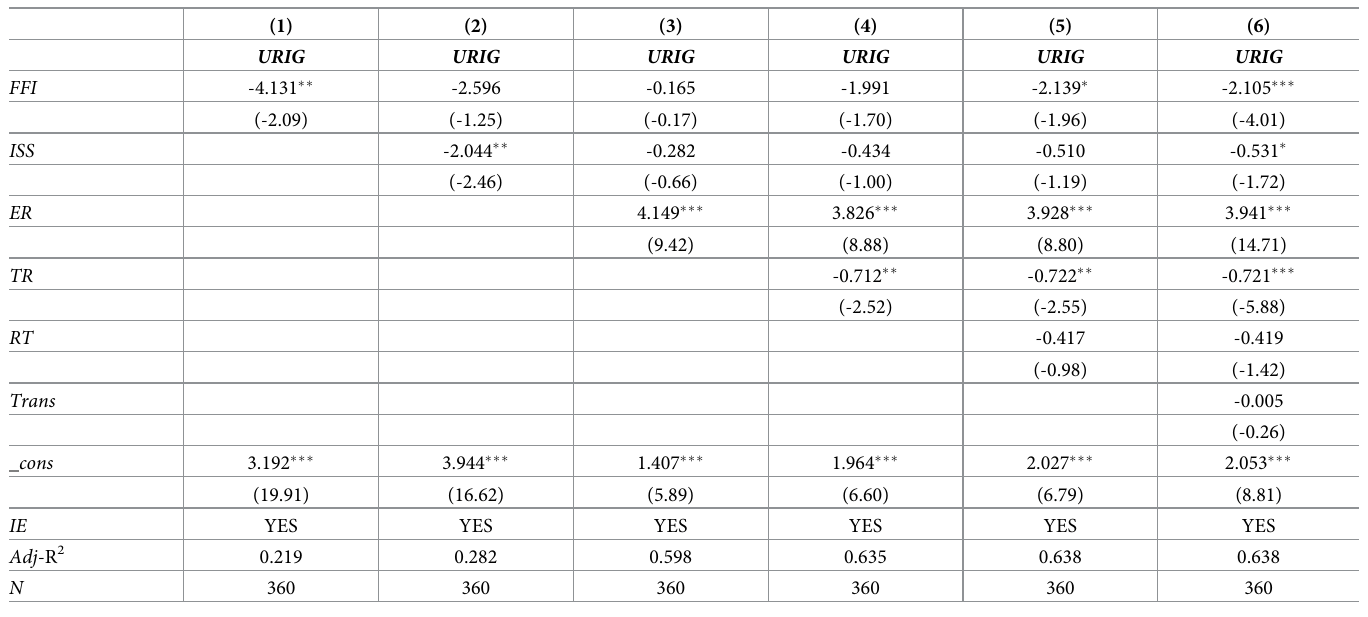
Table 5. Results of the baseline